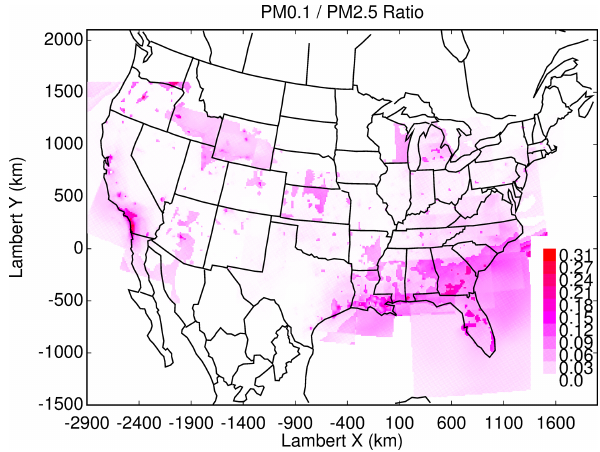
Figure 12. PM 0 . 1 / PM 2 . 5 ratio across the